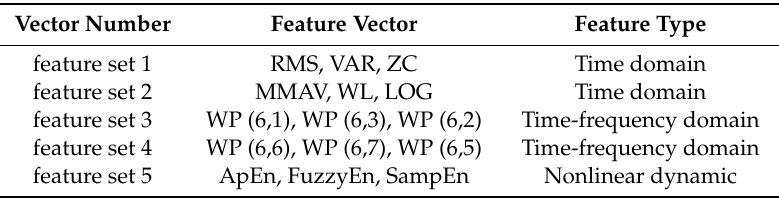
Table 1. Feature